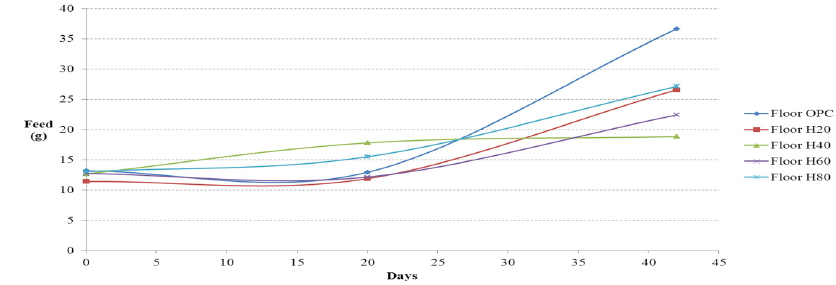
Figure 11. Food intake versus time curves (floor cages).